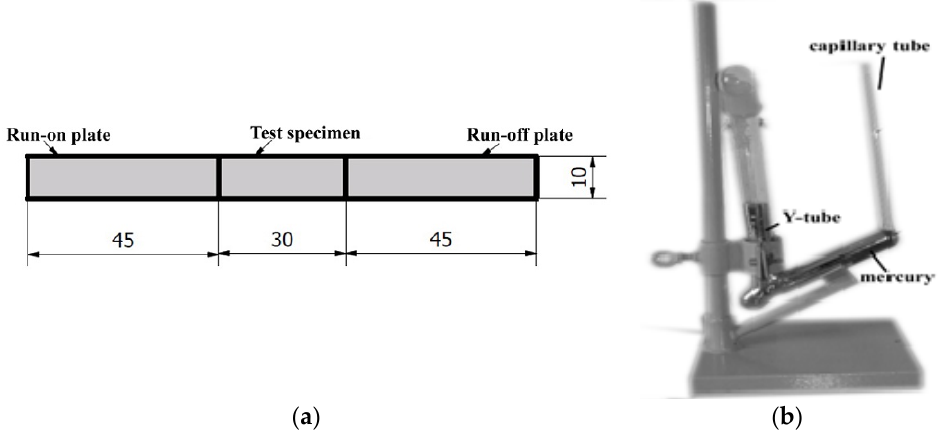
Figure 2. ( a ) The schematic view of specimen for diffusible hydrogen measurement; ( b ) The apparatus